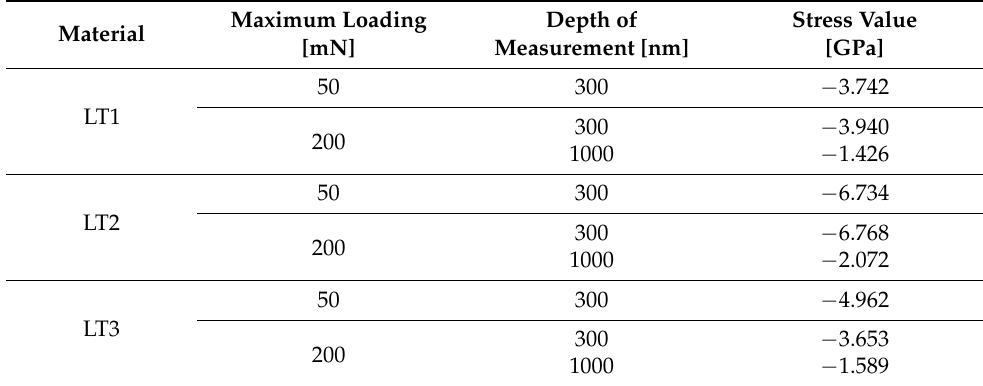
Table 10. List of calculated values of residual stresses of remelted